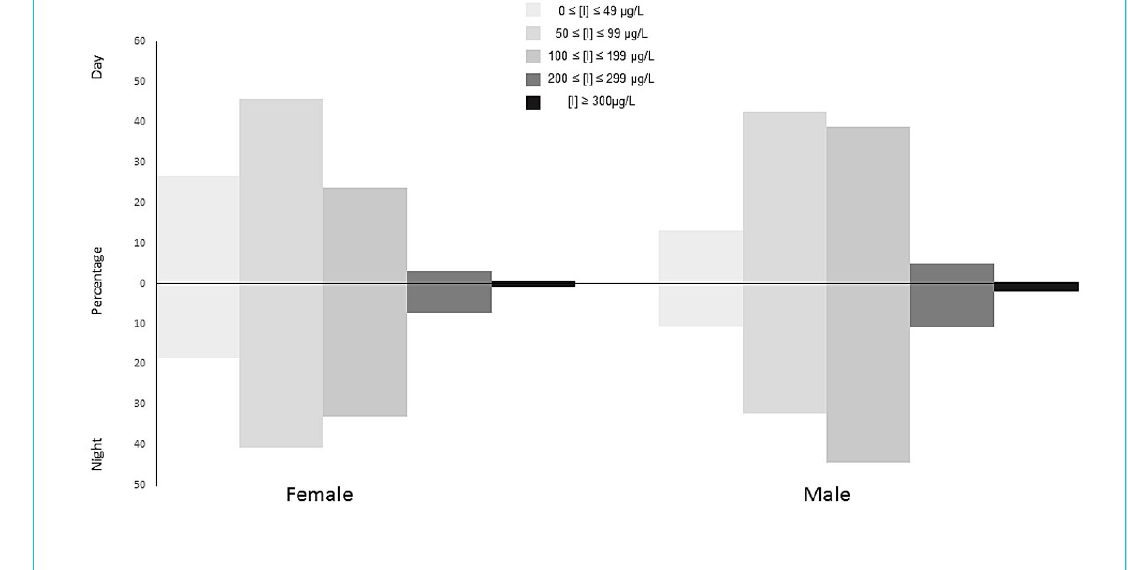
Figure 2: Distribution of urinary iodine concentrations (UICs) for day and night samples in the categories of the WHO